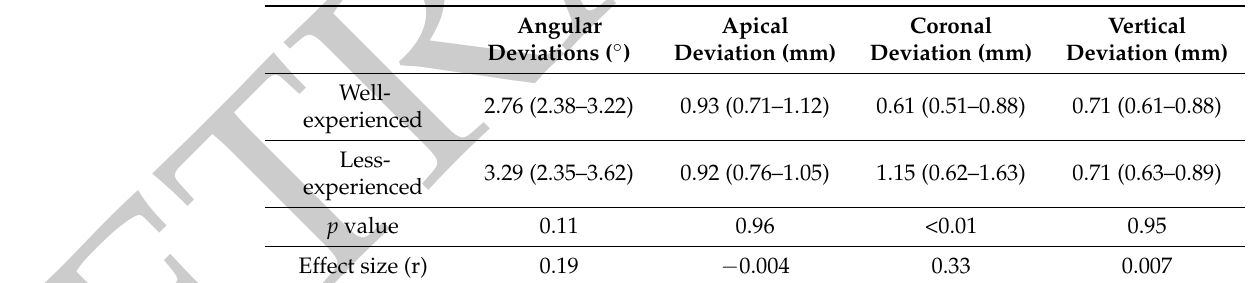
Table 4. Statistical comparisons between more experienced and less experienced surgeons (Mann– Whitney U